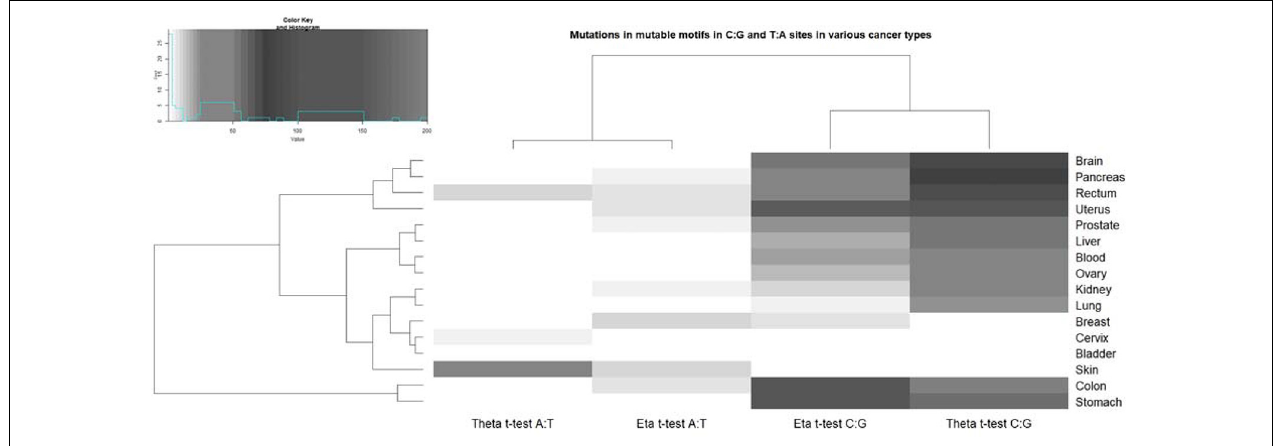
FIGURE 3 | Correlation of pol η (eta) and θ (theta) mutable motifs and the sequence context of somatic mutations. For the actual data, see Supplementary Tables 3, 4 . The intensities of the gray color correspond to the t -test values ( Supplementary Tables 3, 4 ). The unweighted pair group method, with arithmetic mean (UPGMA) clustering of ratio values for the pol η and θ footprints and tissues, is shown to the left and top. The upper left panel shows the distribution of the studied t -test values and correspondence of the t -test values and color intensity (the darker colors correspond to the higher correlation values). A similar plot of ratio values (the ratio being the mean weight of mutated sites divided by the mean weight of non-mutated sites) is shown in the Supplementary Figure 5 . TABLE 1 | Correlation between the sequence context of somatic mutations and mutable motifs in fragments of human immunoglobulin genes. Locus Test Number of Mutations AID/G:C Pol η /G:C Pol θ /G:C Number of Mutations Pol η /A:T Pol θ /A:T V H